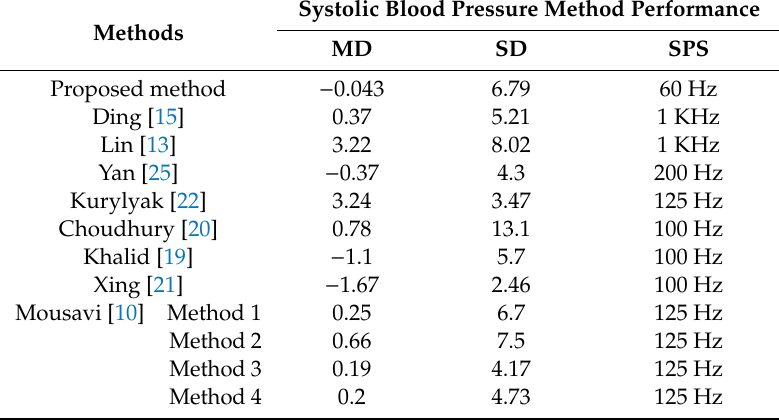
Table 2. Evaluation of the performance of the systolic blood pressure estimation methods (MD—mean di ff erence, SD—standard deviation, SPS—samples per